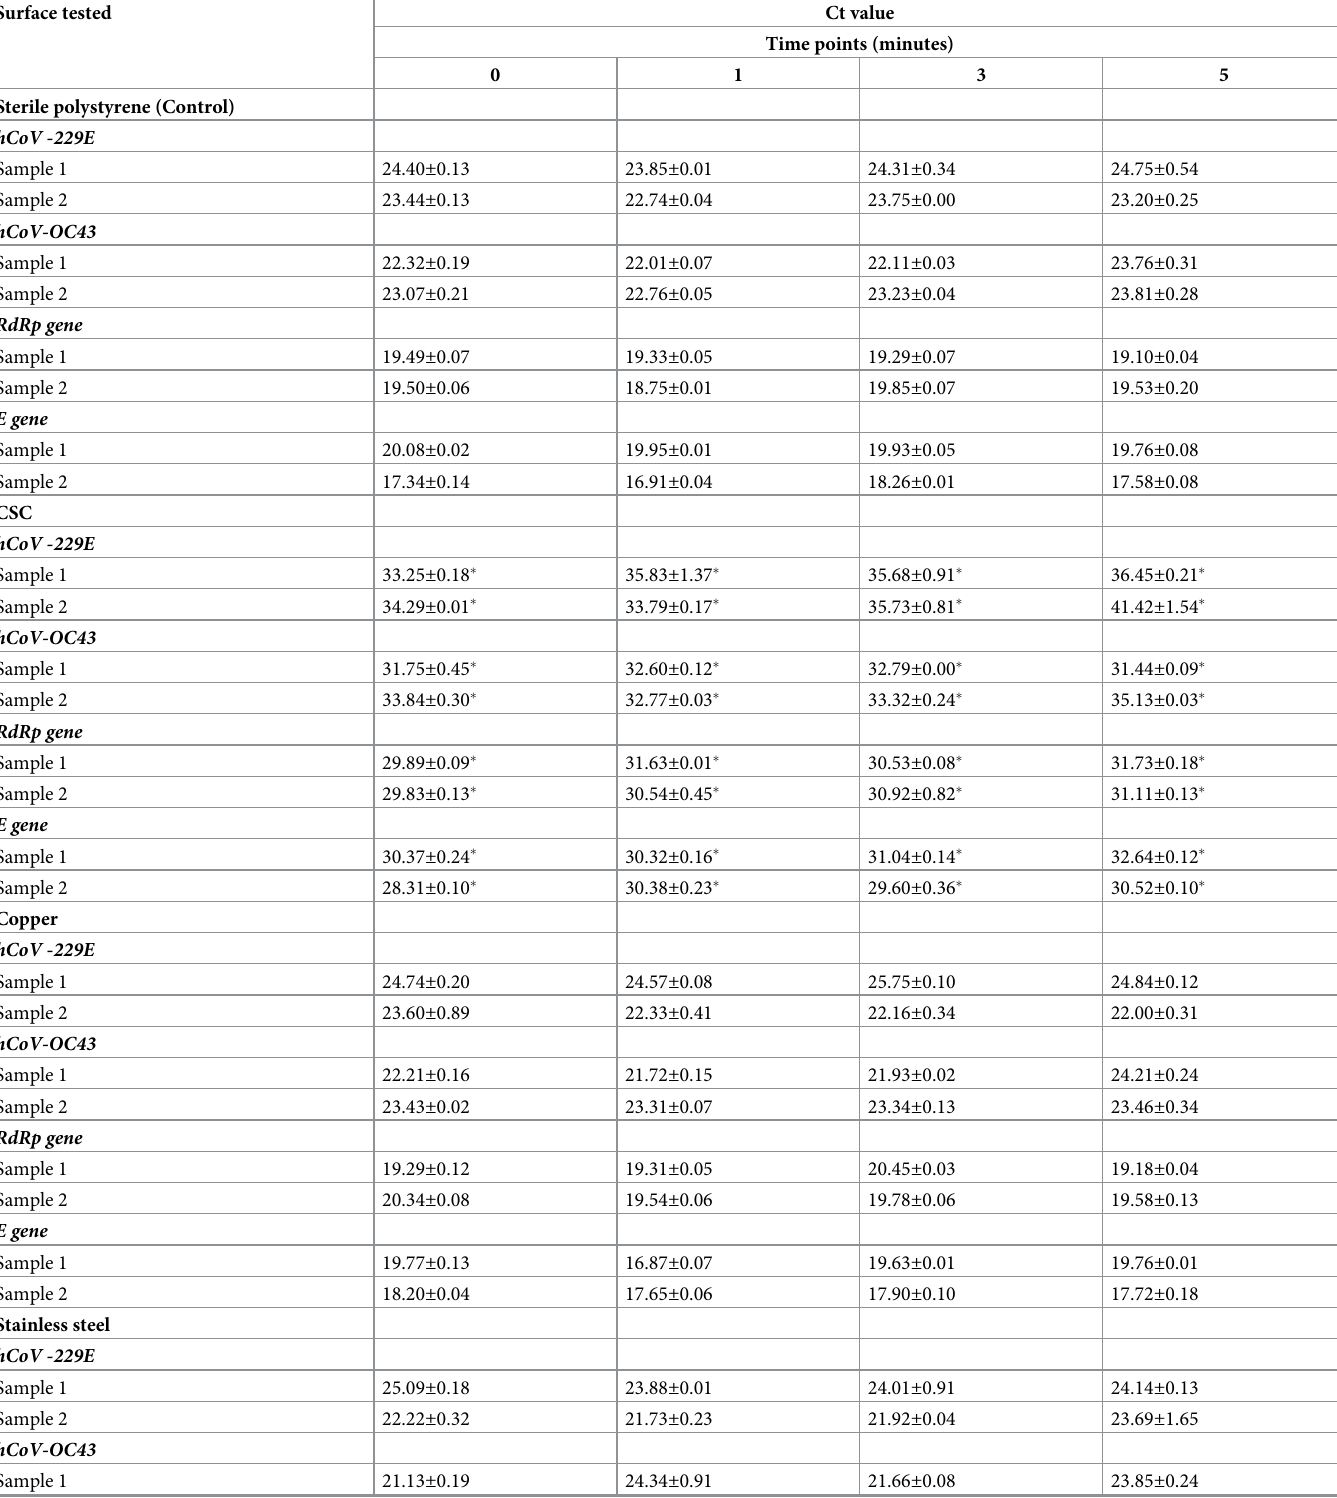
Table 3. The effectiveness of CSC against SARS-CoV-2 in clinical samples by RT-qPCR. Surface